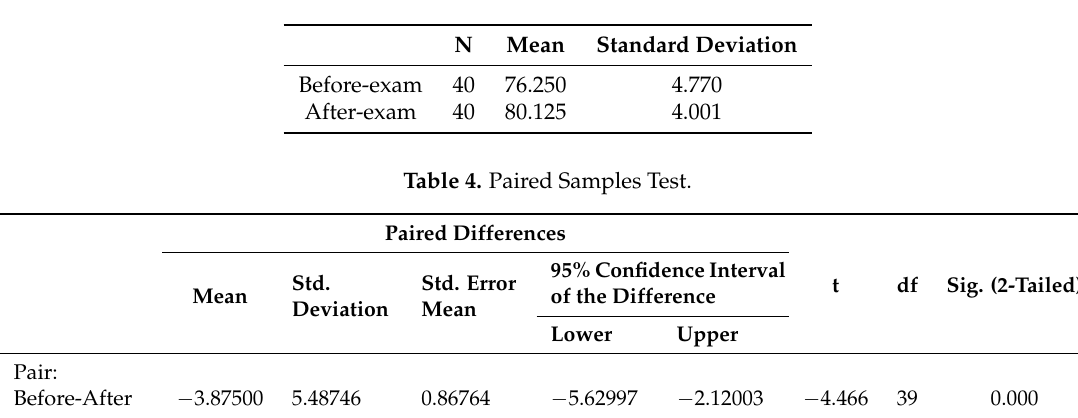
Table 3. Effectiveness evaluation result.